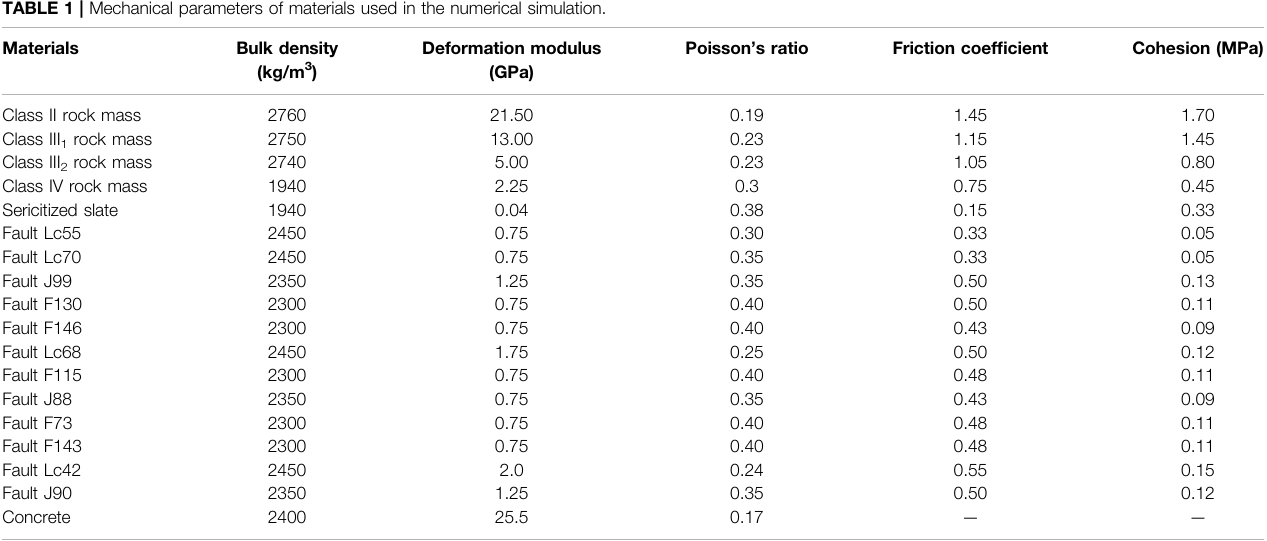
TABLE 1 | Mechanical parameters of materials used in the numerical